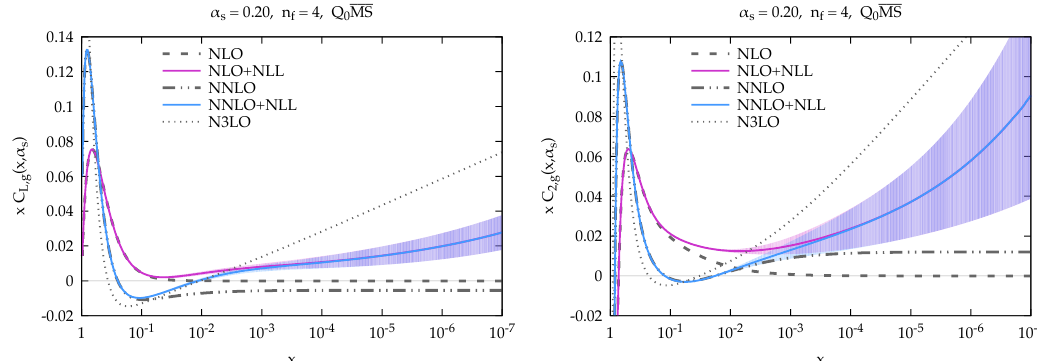
Figure 3 . The resummed and matched massless coe(cid:14)cient functions C L;g (left) and C 2 ;g (right) at NLO+NLL accuracy (solid purple) and at NNLO+NLL accuracy (solid blue). Fixed-order results are also shown in black: NLO in dashed, NNLO in dot-dot-dashed and N 3 LO in dotted. The plots are for (cid:11) s = 0 : 2 and n f = 4 in the Q 0 MS scheme. We note that di(cid:11)erence between Q 0 MS and MS for the (cid:12)xed-order results is immaterial at this accuracy, except for the N 3 LO contribution to F 2 , which is shown in